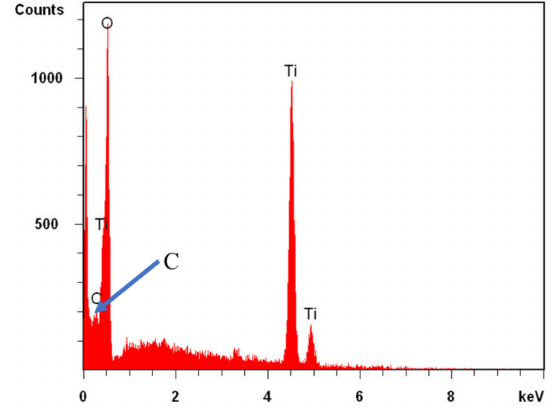
Figure 4. The EDX spectra of modified TNTAs indicating the elemental composition Ti and O with a ratio of Ti:O = 1:2 and the presence of carbon in TNTAs.